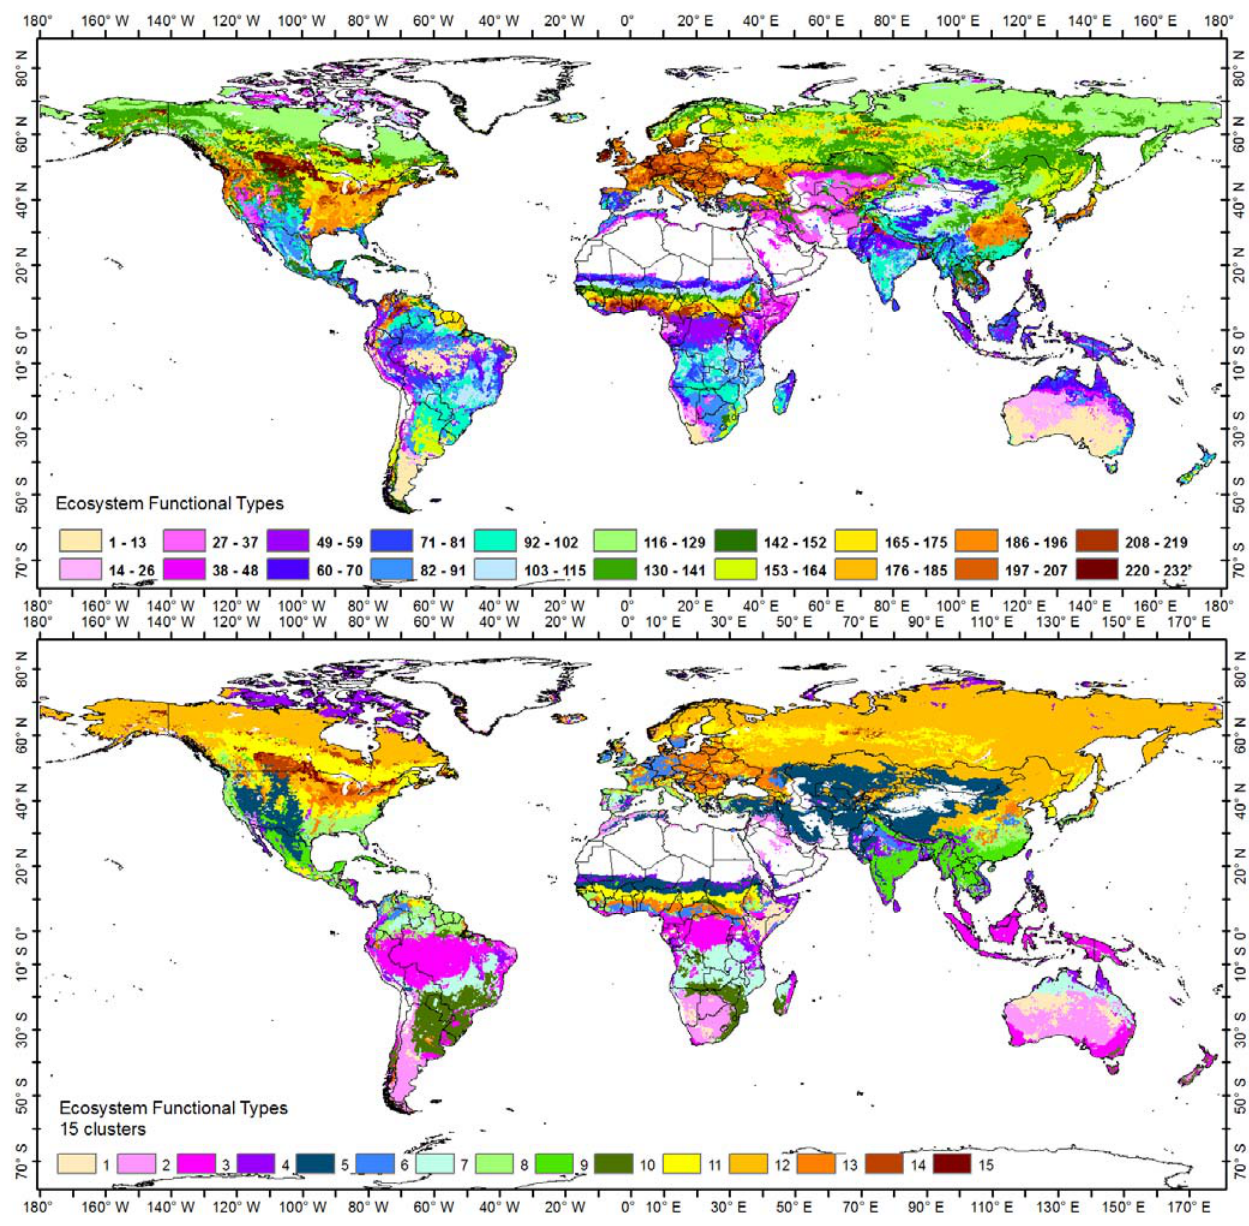
Figure 2. Isodata classification of the spatial patterns of the first five rotated Principal Components ( top ). The iterative classification resulted in 232 Ecosystem Functional Types (EFTs). By minimizing variance within the classes the EFTs were regrouped into 15 major clusters ( bottom ). White areas represent pixels without vegetation